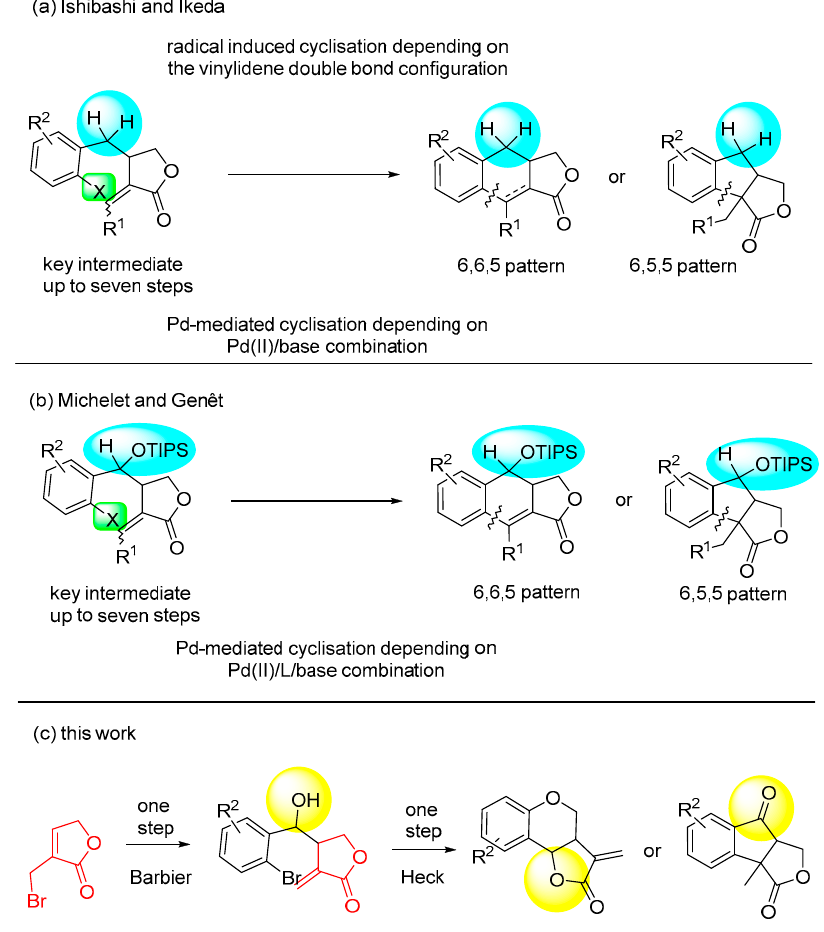
Figure 2. Selective access to 6,6,5 or 6,5,5 polycyclic pattern from α -ylidene γ -lactone. ( a )